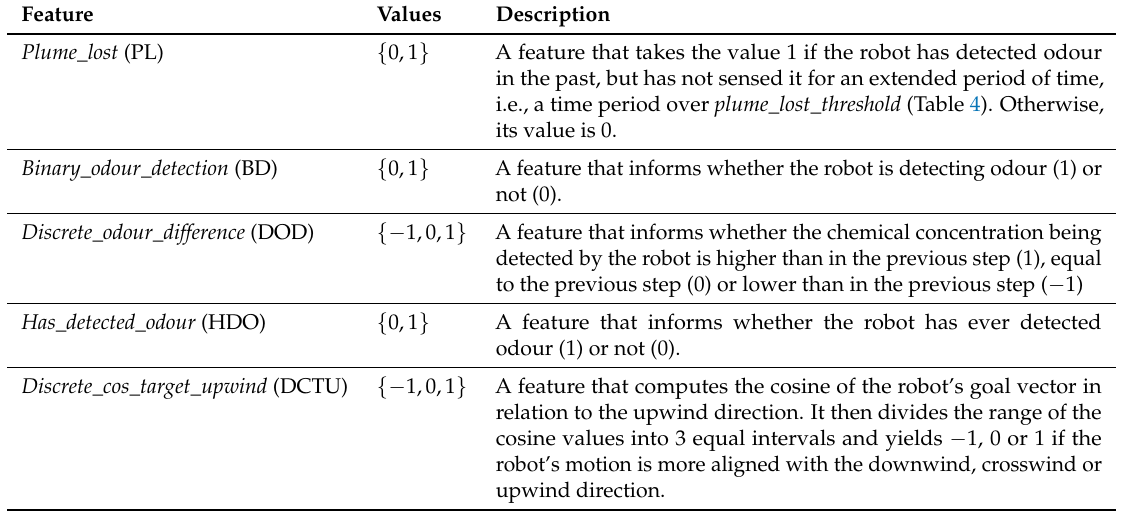
Table 3. Designed